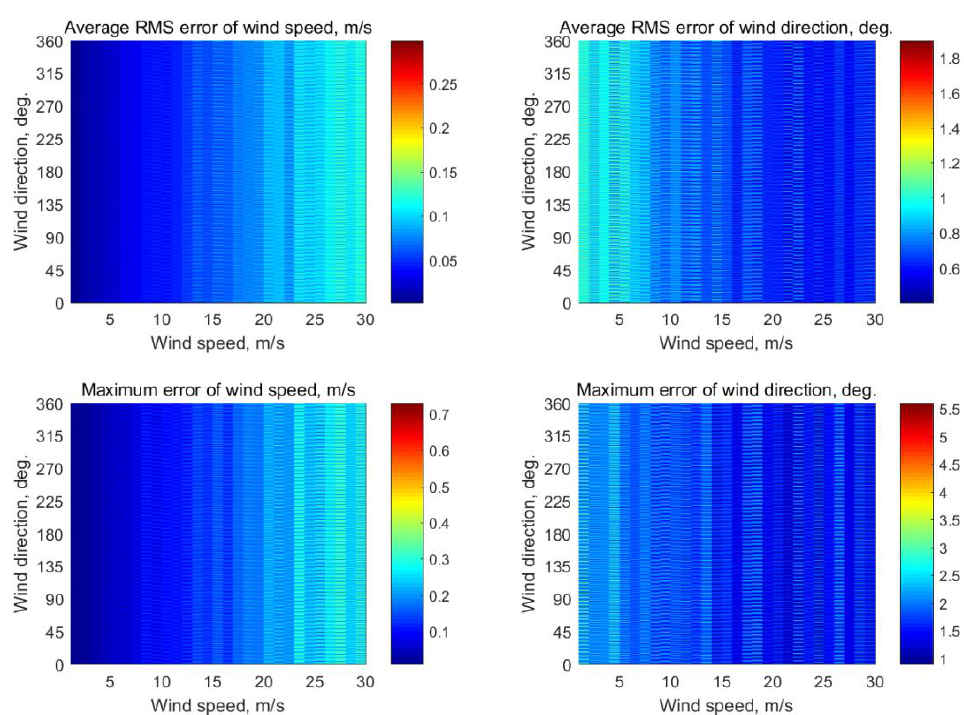
Figure A17. Simulation results of the use of three incidence angles of 45°, 50°, and 55° for wind retrieval.